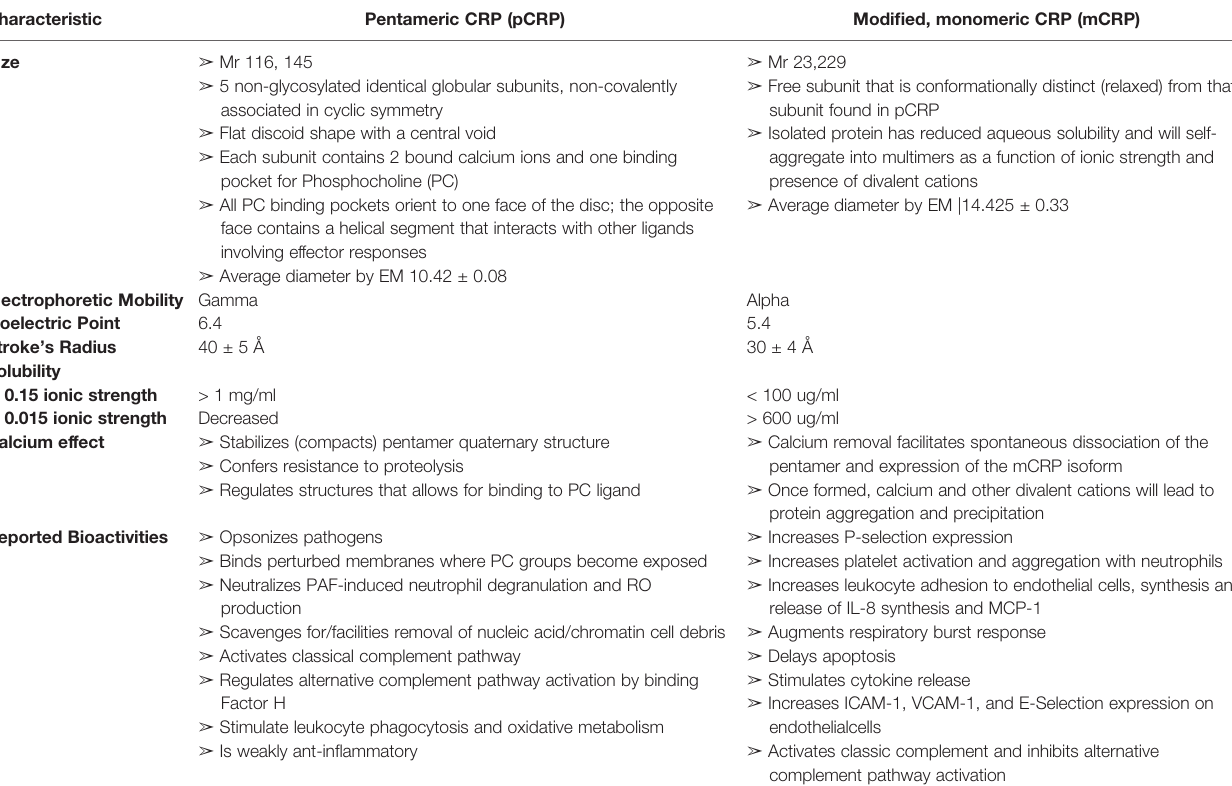
TABLE 1 | Comparison of Biochemical Characteristics of Pentameric (pCRP) and modi fi ed, monomeric (mCRP) C-reactive protein.